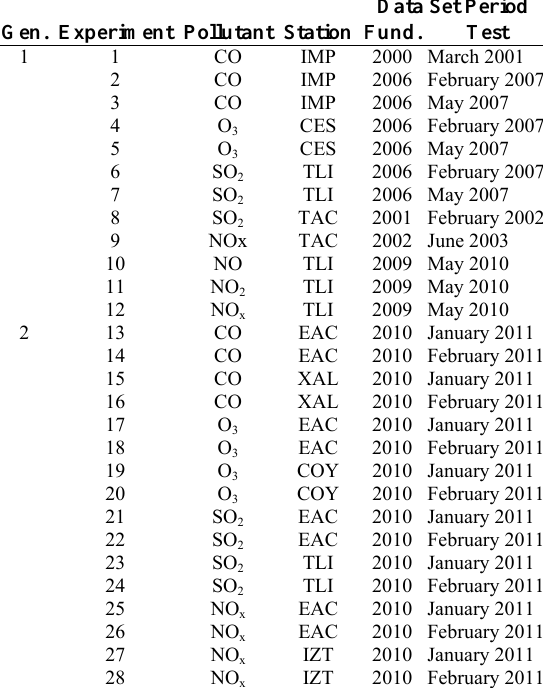
Table 3. Configurations of experiments; Gen. means “Generation” and Fund. means